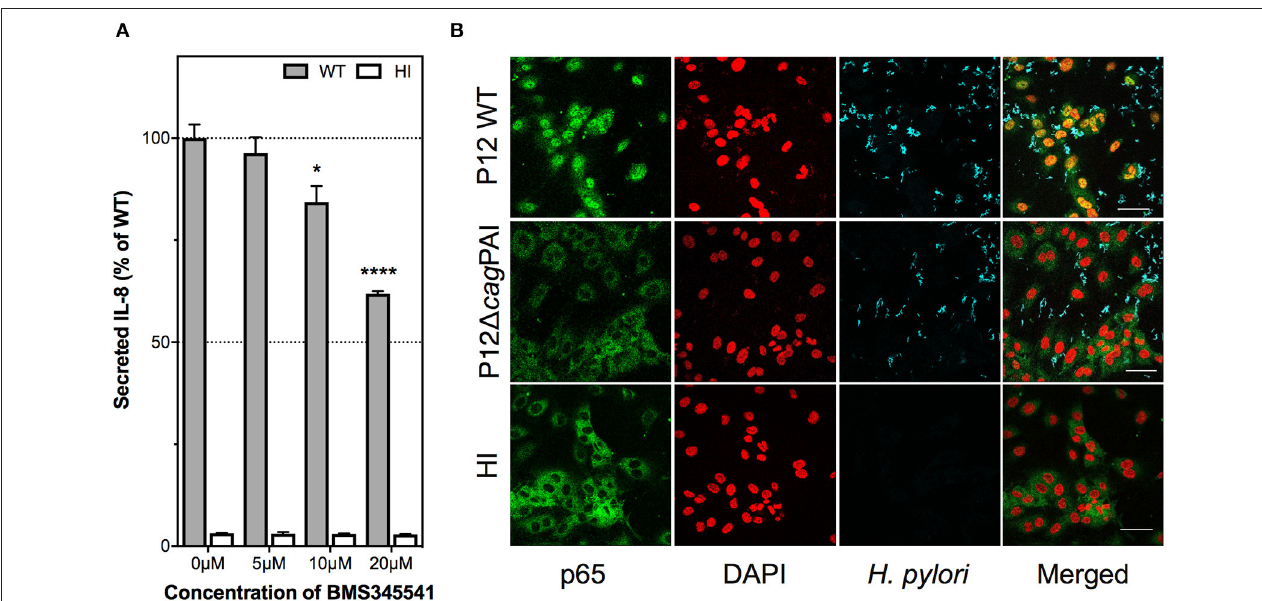
FIGURE 7 | Contribution of NF- κ B activation to H. pylori –induced IL-8 secretion by human endothelial cells. (A) IL-8 induction is dependent upon NF- κ B activation. HUVECs were pre-treated with BMS345541 at 5, 10, or 20 µ M prior to inoculation with HI or H. pylori P12. Spent culture media was harvested at 24 hpi and assayed by ELISA for secreted IL-8; IL-8 levels are expressed as the mean percentage of that determined with P12 WT-infected HUVECs. Error bars denote SEM, N = 2; statistical analysis of inhibitor dose-response by two-way ANOVA (Tukey’s multiple comparisons post-test); significant differences compared to 0 µ M are shown; * p < 0.05; **** p < 0.0001. (B) H. pylori activates nuclear translocation of NF- κ B subunit p65 upon infection of HUVECs. HUVECs inoculated with HI broth, or H. pylori strains P12 WT or P12 cag PAI mutant (MOI = 30) were fixed at 3 hpi, and immunolabeled for NF- κ B p65 (green) and H. pylori (blue); nuclei were counterstained with DAPI (red); yellow/orange in merged images denotes nuclear p65. Scale bar, 50 µ m. Images shown are representative of two independent